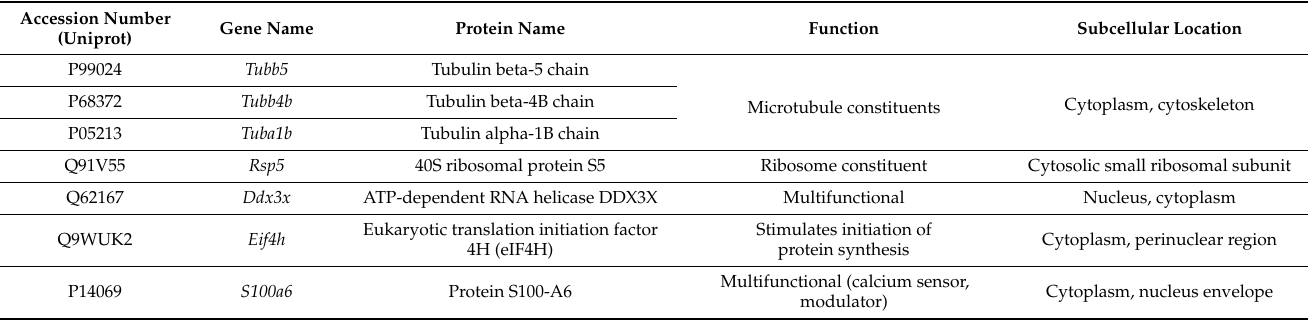
Table 1. Candidate GapA interaction partners identified by SILAC–Pull-Down–MS/MS